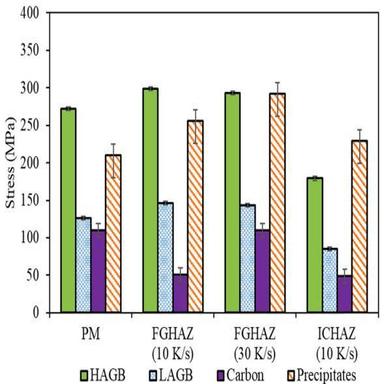
Contributions to YS of dominant strengthening mechanisms for PM, FGHAZ (10 K/s), FGHAZ (30 K/s), and ICHAZ (10 K/s).